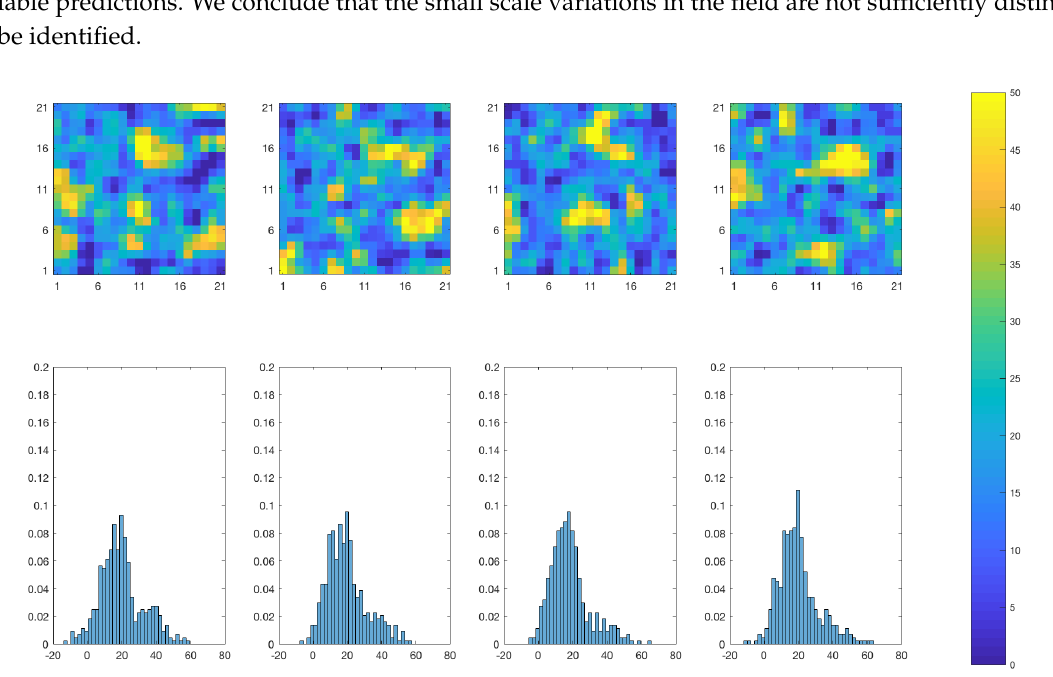
Figure 20. SEnKS approach: Realizations from the posterior distribution f ( r 0 | d 0: T ) of the initial temperature field at time T = 50. Upper panels: the colorbar gives the temperature in ◦ C. Lower panels: the horizontal axes represent the temperature ( ◦ C), the vertical axes represent the relative prevalence of each temperature value for the realization right